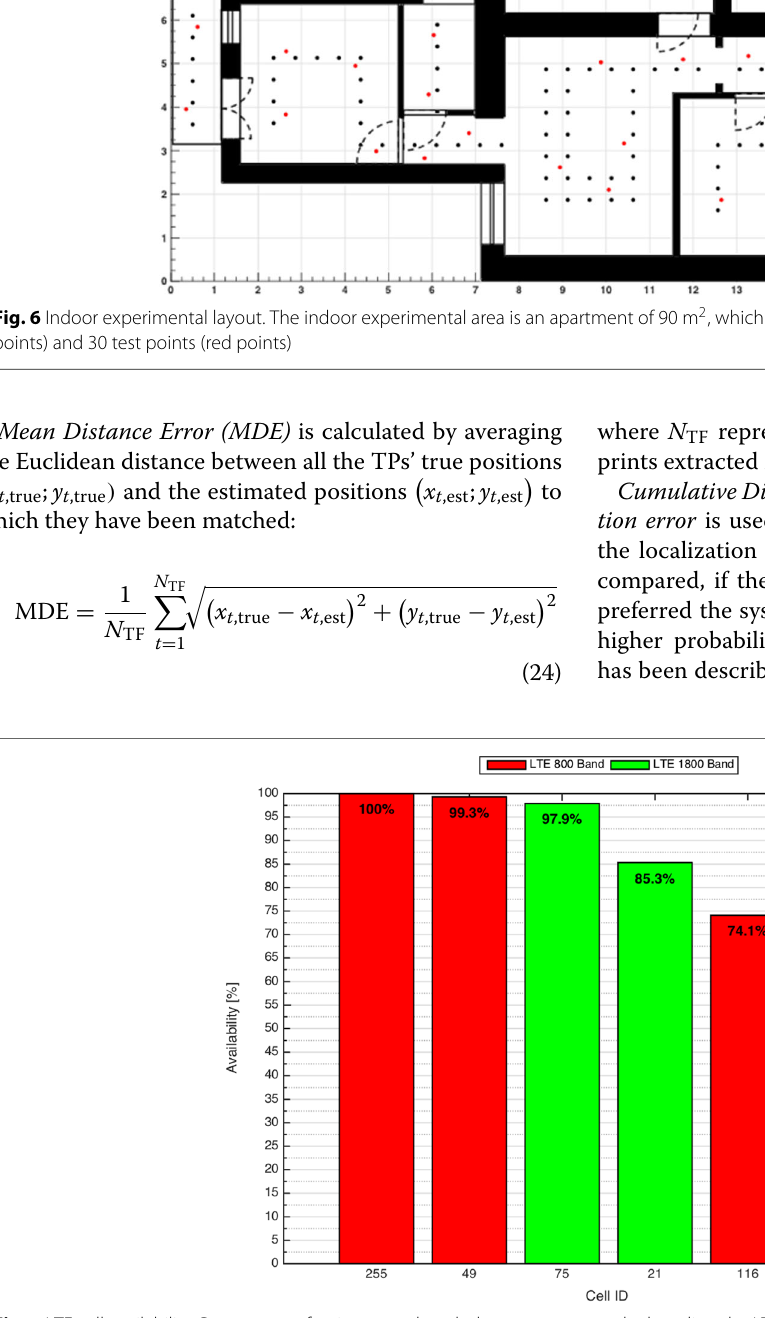
Fig. 7 LTE cell availability. Percentage of points over the whole test area correctly decoding the LTE cells taken under